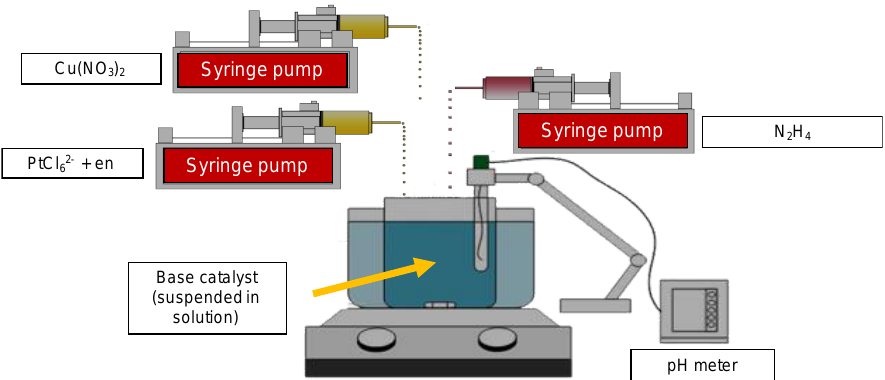
Figure 1. Image of the experimental setup for continuous co-electroless deposition (co-ED). New Era Pump Systems NE-300 pumps were used to add reagents during ED. A pH meter continuously monitored the pH of the ED bath. Bath temperature was maintained (in this case at 25 ◦ C) but could be controlled up to 90 ◦ C using a digital, PID heated stirrer to regulate temperature and stir the bath. For comparison, a commercial 20 wt % Pt/XC72 sample was evaluated for methanol electrooxidation. This catalyst was evaluated as-received and characterized by STEM, XRD, and H 2 –O 2 titration to give average diameter d: d(STEM) = 3 ± 1 nm, d(XRD) = 3.2 nm, and d(H 2 –O 2 titration) = 6.1 ± 0.3